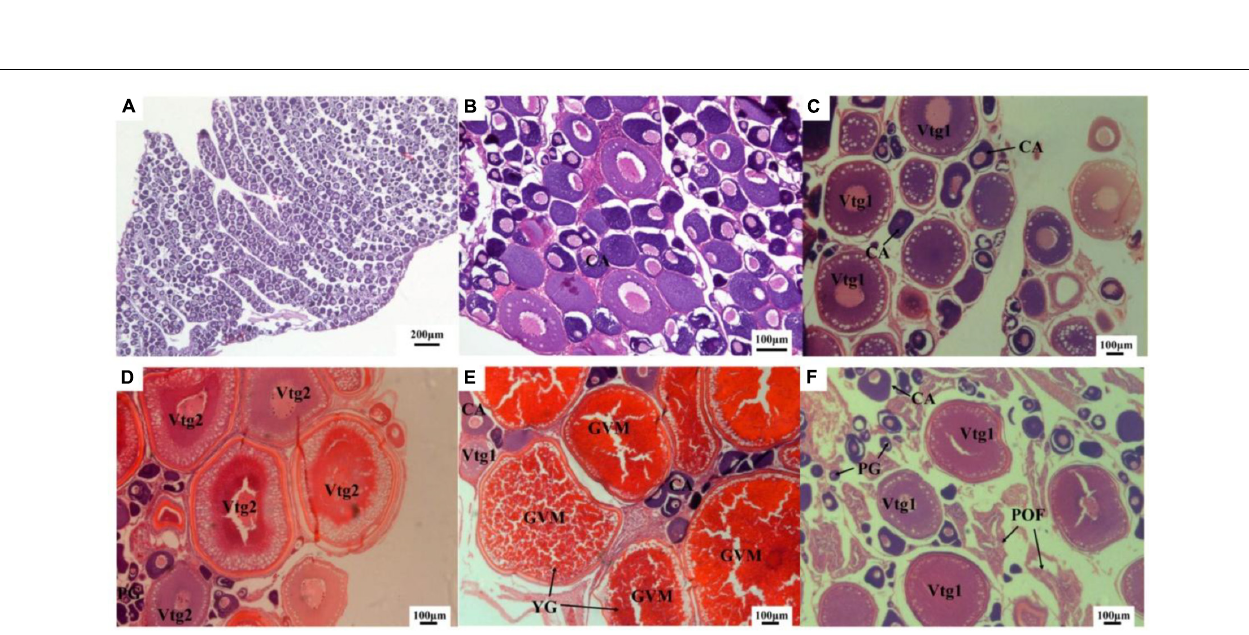
Frontiers in Ecology and Evolution |